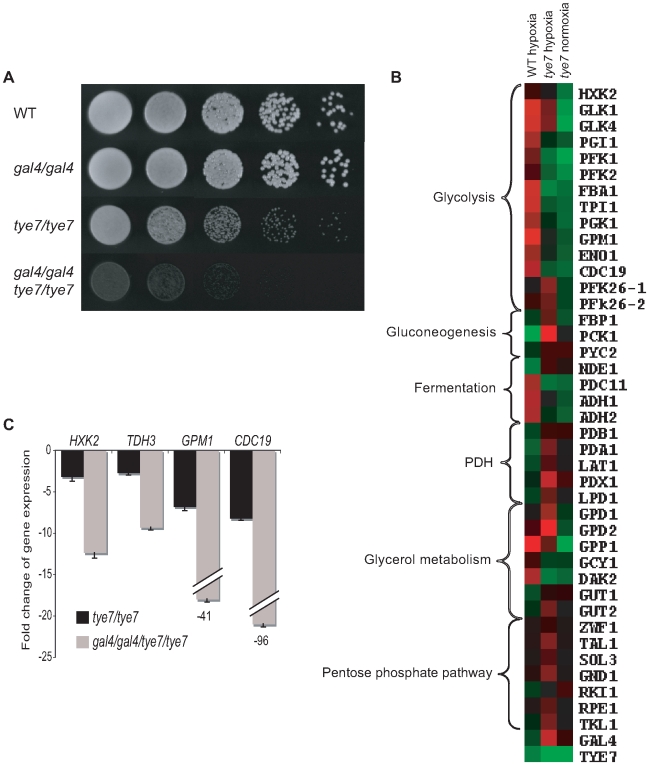

TYE7 and GAL4 are important for hypoxic growth and the induction of glycolytic genes in a low oxygen environment.(A) Cells were serially diluted, plated on YPD, and incubated in an anaerobic chamber at 30°C for 4 days. The chamber was flushed daily with nitrogen. Due to the space limitation of the chamber, the revertant strains were unable to be spotted on the same plate. A second experiment including the revertant strains was done on two separate plates to verify the results (Figure S5B). (B) Heat map displays were created as described in Figure 4. Transcription profiles of selected metabolic genes for (from left to right) BWP17 hypoxia relative to BWP17 normoxia, tye7 hypoxia relative to BWP17 hypoxia, and tye7 normoxia relative to BWP17 normoxia. The expression levels of these and other metabolic genes are given in Table S7. (C) The expression levels of several glycolytic genes were measured by qPCR in the tye7 and gal4tye7 strains relative to the wild type (BWP17) after 30 min of growth under hypoxic conditions. ACT1 was used as the reference.